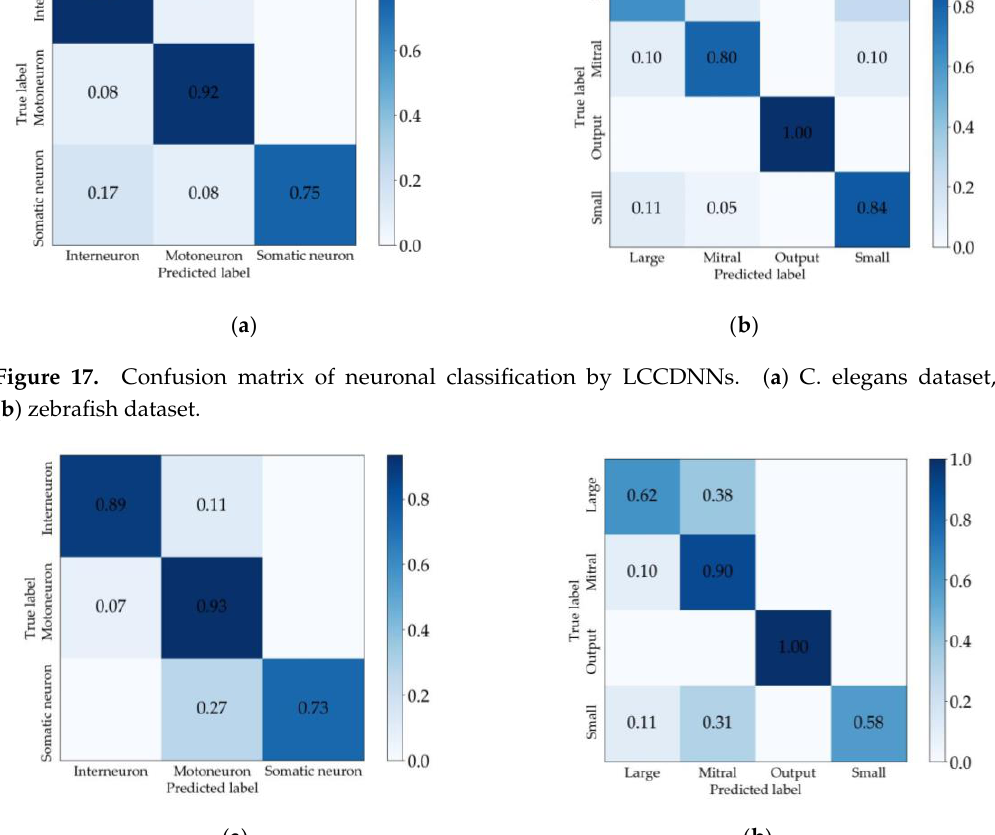
Figure 18. Confusion matrices of neuronal classification by FCCDNNs. ( a ) C. elegans dataset, ( b ) zebrafish dataset.